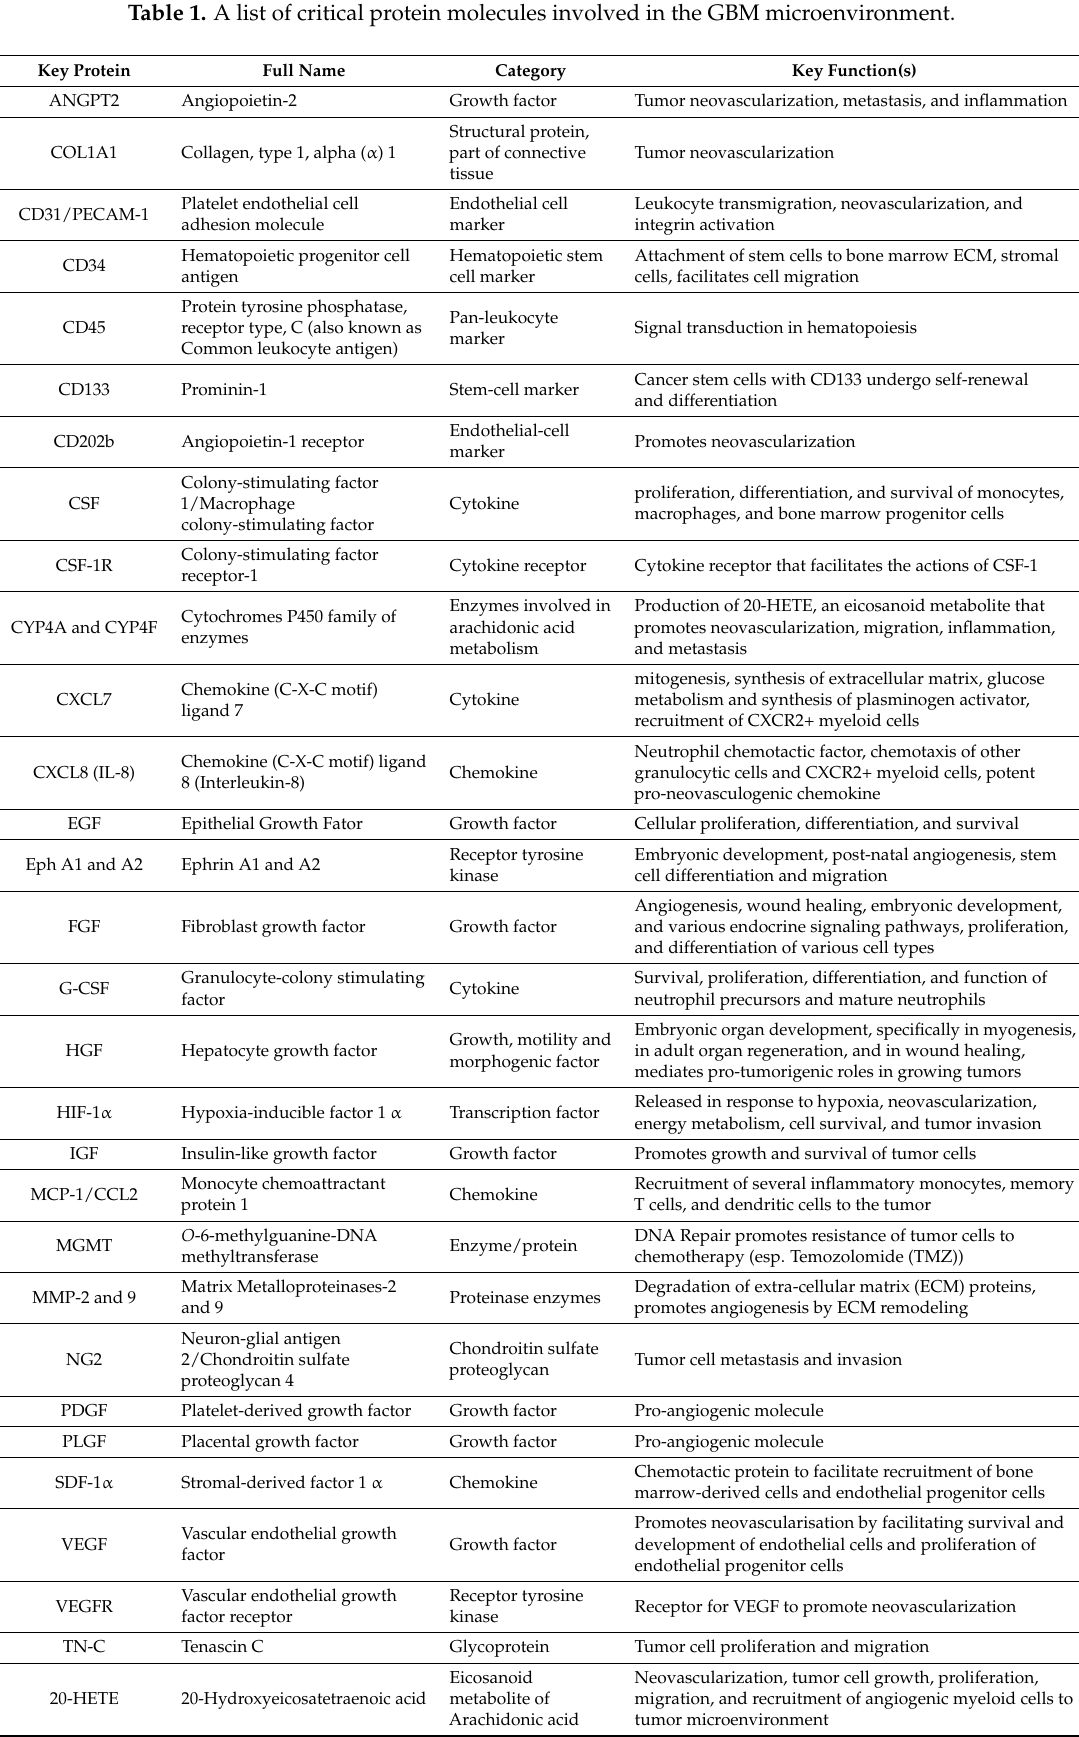
Table 1. A list of critical protein molecules involved in the GBM